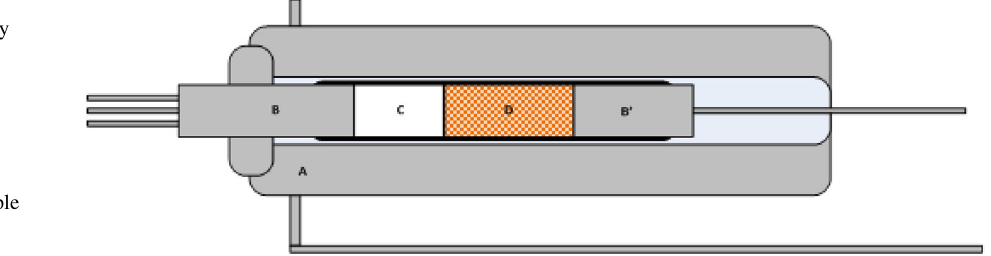
coreholder for Amott–Harvey test with carbonated water, where A casing coreholder, B input diffuser with three injection lines, B 0 output diffuser with a single line , C adaptation in coreholder, aluminum ring, D rock sample